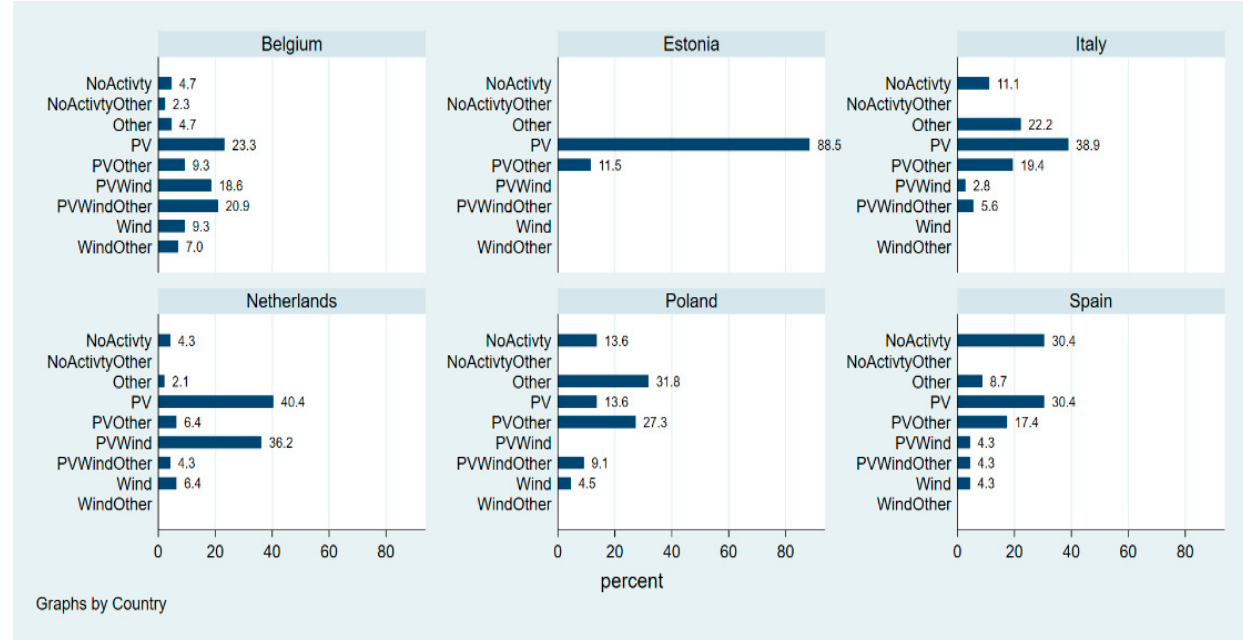
Figure A2. Renewable Energy Generation Combinations. Results in percentages.